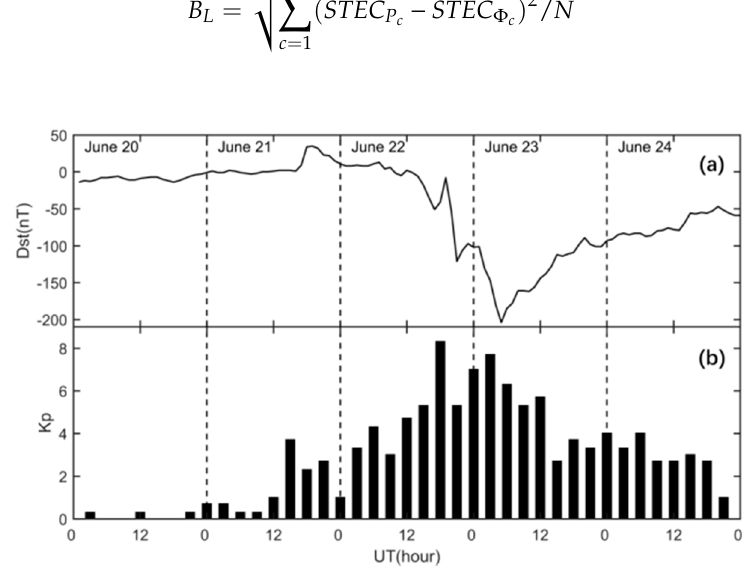
Figure 6 . The variations in (cid:1830)(cid:1871)(cid:1872) index and (cid:1837)(cid:1868) index from June 20 to 24, 2015. Figure 6. The variations in Dst index and Kp index from 20 to 24 June